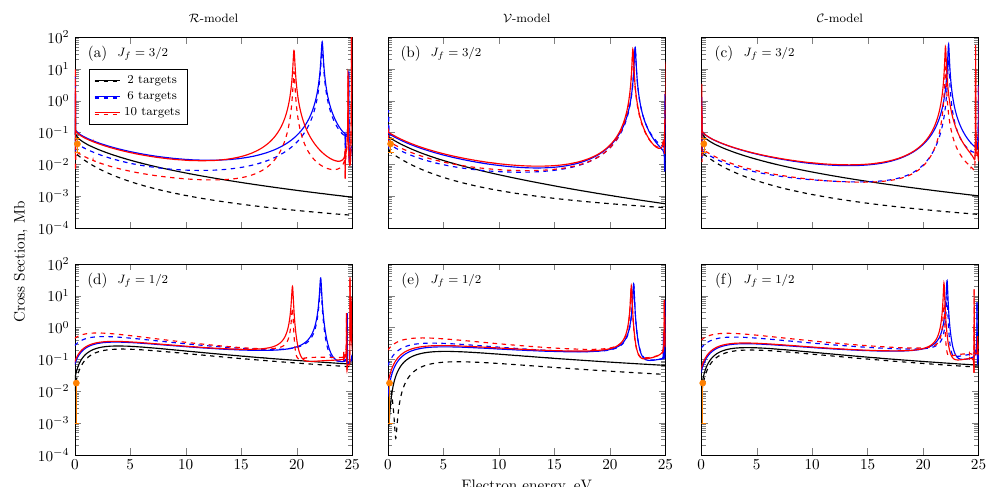
Figure 1. Photoionization cross-section of 2 s 2 2 p 5 ( P 1/2 ) 3 s [ 1/2 ] 0 state of neon to 2 s 2 2 p 5 ( 2 P 3/2 ) (upper row) and 2 s 2 2 p 5 ( 2 P 1/2 ) (bottom row). Calculations are performed within R - ( a , d ), V - ( b , e ) and C -model ( c , f ). Solid lines are for calculations in the length gauge and dashed lines in the velocity gauge; different colors mark the number of accounted target states: two (black), six (blue) and ten (red). Experimental data points are taken from [38] and labeled by orange.